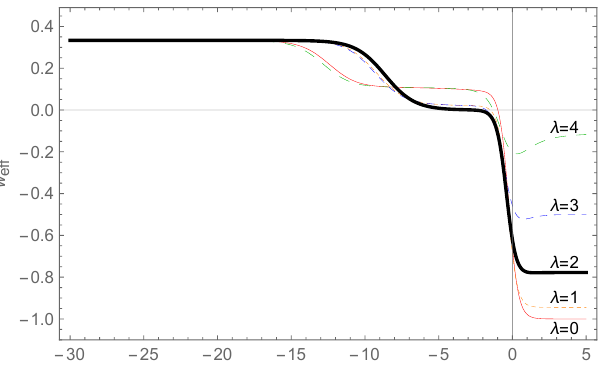
Figure 4. Evolution of the effective equation-of-state parameter w eff for different values of λ . Initially, the evolution is dominated by radiation, implying w eff = 1/3 for all λ ’s. At certain point, baryonic and dark matter become dominant and w eff decreases gradually from 1/3 to a near-zero value which depends on λ . In recent times, dark energy becomes dominant and w eff assumes negatives values; for w eff ≤ − 1/3 it signals an accelerated expansion of the